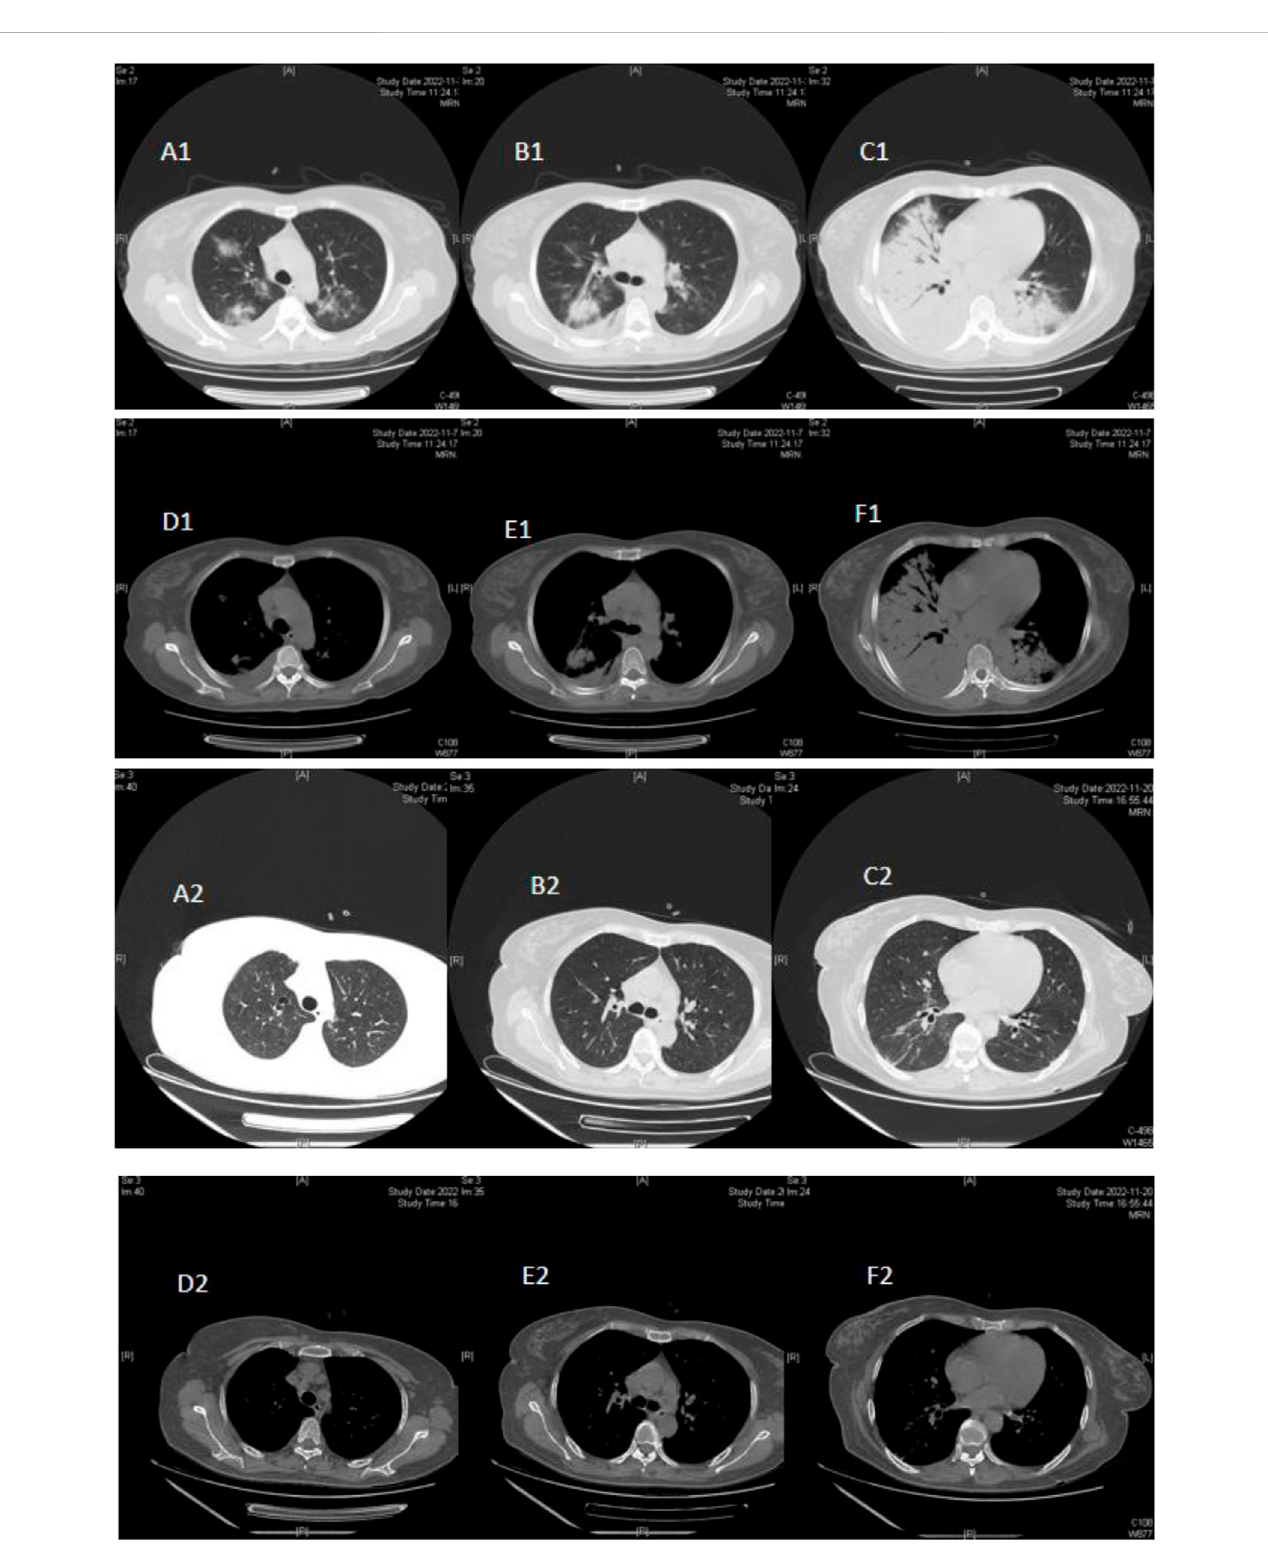
FIGURE 3 Case 3, a 50-year-old female, was hospitalized on 7 November, 2022, due to a “ cough and fever for 6 days. ” On admission (November 7), pulmonary CT showed, double lower lung consolidation, double upper lung ground-glass change, consolidation (mainly right lung lesions), and a small amount of pleural effusion (A1 – F1) ontherightside.Afterdoxycyclinetreatment,thelungCTreexaminationon20November,2022,showedthatthebilaterallunglesionswere absorbed and improved (A2 – F2)